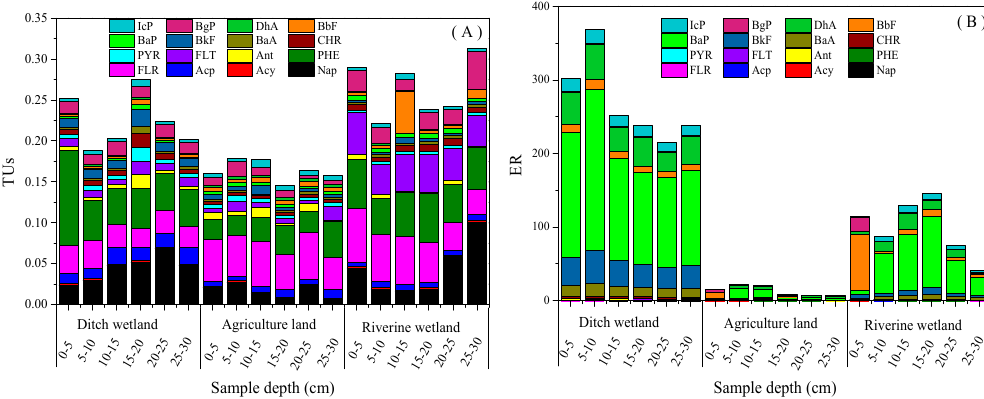
Figure 4. Total toxic units ( A ) and environmental risk of benzo[ a ]pyrene toxic equivalent (TEQ-B a P) ( B ) of PAHs in sediment/soil cores by depth (0–5 cm sediment/soil layer, 5–10 cm sediment/soil